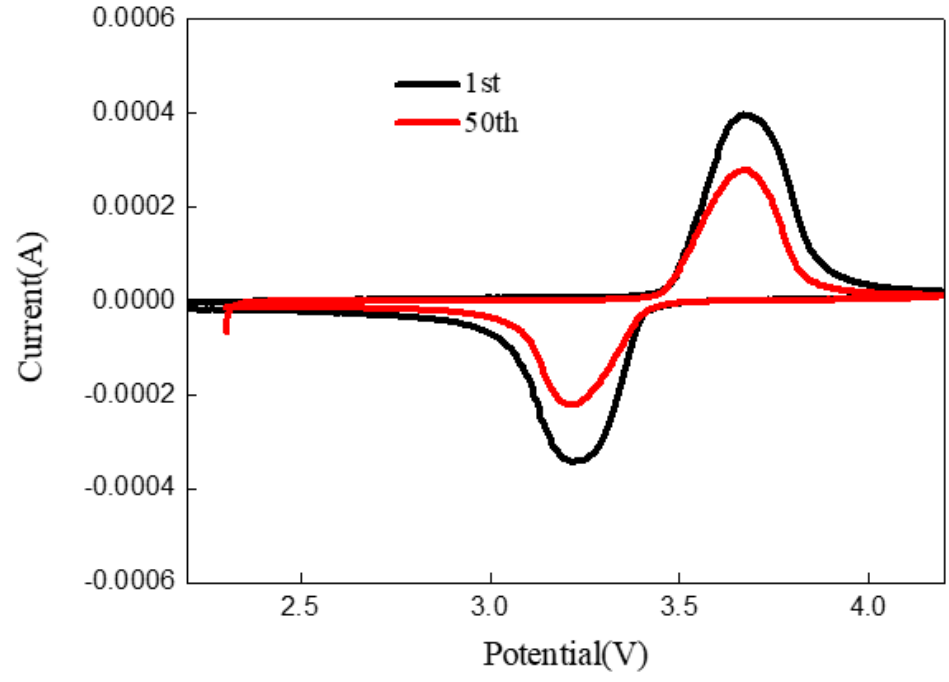
Figure 8. Cyclic voltammetry curves of LFP/C-xZnO (x = 3 wt%) after 1 and 50